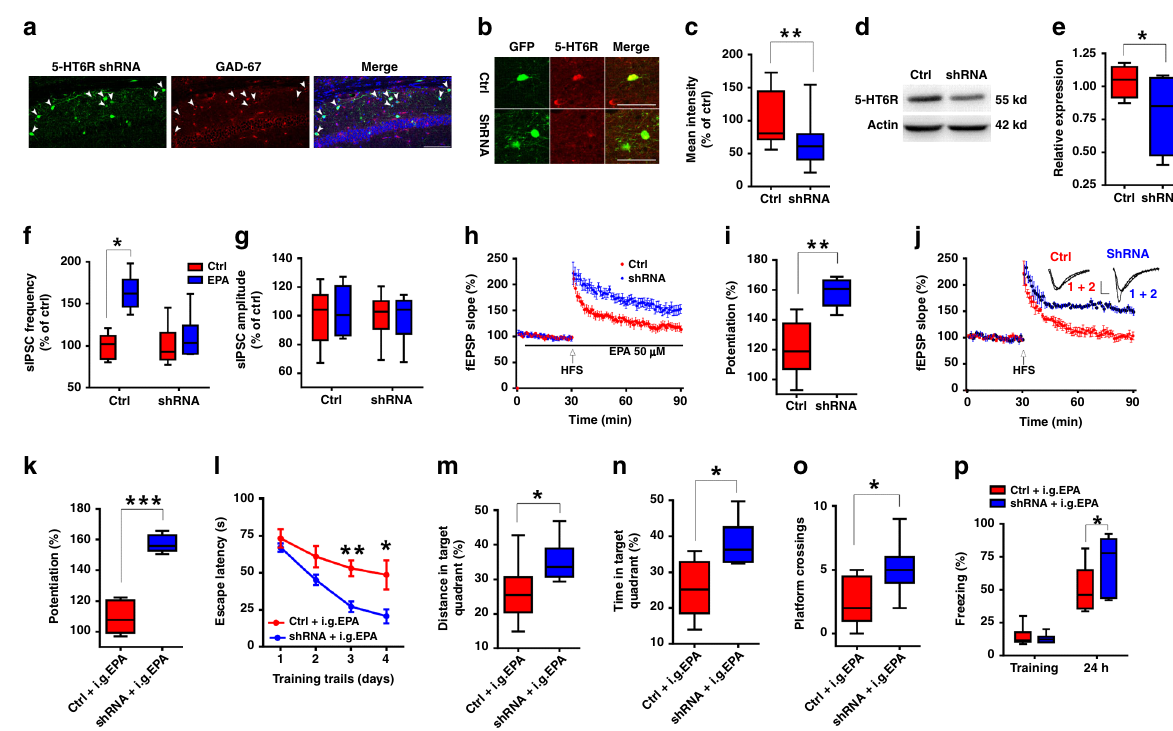
Fig. 7 EPA impaired behaviors and synaptic plasticity via the 5-HT 6 R on GABAergic interneurons. a Representative fl uorescence images showing most of the cells infected with pAAV-CAG-DIO-5-HT 6 R-EGFP (shRNA) vectors are GABAergic neurons in the CA1 region of GAD-Cre mice. Scale bar: 100 µ m. b Representative fl uorescence images showing the knockdown of 5-HT 6 R in CA1 GABAergic neurons infected with pAAV-CAG-DIO-5-HT 6 R-EGFP (shRNA) vectors in GAD-Cre mice. Scale bar: 50 µ m. c Histogram showing average fl uorescence intensity (red) in the CA1 neurons from GAD-Cre mice that were injected with pAAV-CAG-DIO-EGFP (control) and shRNA virus (Ctrl group: n = 20 cells from four mice; shRNA group: n = 32 cells from fi ve mice; two-tailed Student ’ s t -test, P = 0.002). The fl uorescence intensity of the 5-HT 6 R-positive neurons (red) merged with GFP (green) was plotted using the same imaging conditions for every slice. d , e Western blots showing 5-HT 6 R reduction after shRNA virus injection ( n = 4 experiments/group; two- tailed Student ’ s t -test, P = 0.032). f – i Knocking down 5-HT 6 R in the GABAergic interneurons prevented EPA-induced enhancement of sIPSC frequency ( n = 8 cells/group; two-tailed Student ’ s t -test; f : Ctrl, P = 0.021 and shRNA, P = 0.505, g : Ctrl, P = 0.789 and shRNA, P = 0.917) and EPA-impaired LTP ( h , i: n = 7 – 8 slices/group; two-tailed Student ’ s t -test, P = 0.001). Scale bars: 0.5 mV, 5 ms. ( j - p ) The i.g. administration of EPA did not impair LTP ( j , k: n = 7 slices/group; two-tailed Student ’ s t -test; P < 0.0001) or learning and memory (MWM test: n = 9 – 10 mice/group; l: repeated measures two-way ANOVA, F (1, 68) = 43.369, P = 0.003; m: two-tailed Student ’ s t -test; P = 0.029; n: two-tailed Student ’ s t -test; P = 0.045; o: two-tailed Student ’ s t -test; P = 0.002. fear conditioning test in p : n = 10 – 11 mice/group; two-tailed Student ’ s t -test; P = 0.038) after knockdown of 5-HT 6 R in the CA1 GABAergic interneurons. Data show mean ± s.e.m. * P < 0.05, ** P < 0.01, *** P <